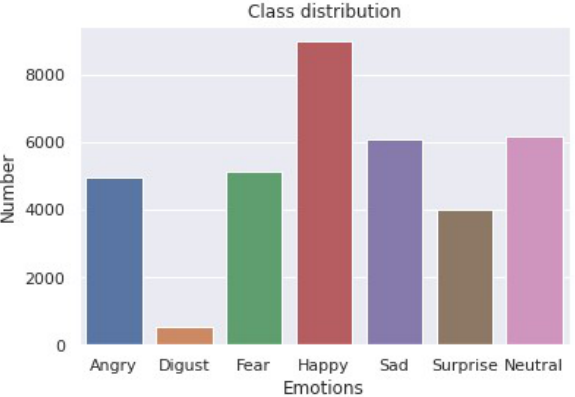
Figure 3 . Distribution of the emotion classes on the